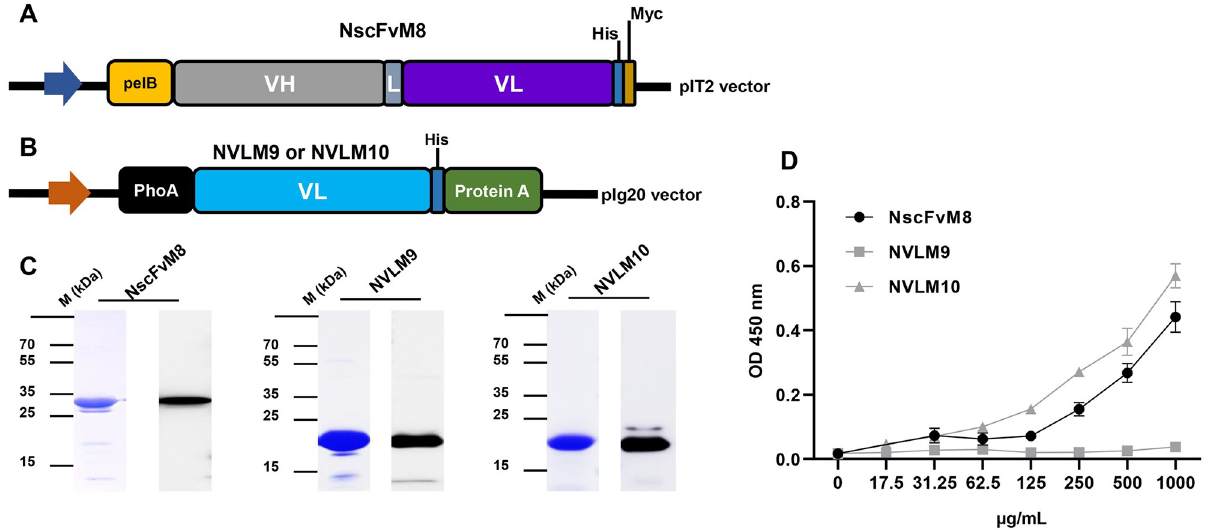
Fig 3. Production of selected candidates in E . coli and their respective virion binding affinities. (A) Expression vector of a single-chain variable fragment candidate, NscFvM8, in a pIT2 vector fused with pelB at the N terminal, and a His, cmyc tag at the C terminal. (B) Expression vector of 2 different single-domain V L candidates, NVLM9 and MVLM10. The single-domain V L genes were amplified and inserted into the pIg20 vector containing a PhoA signal peptide at the N terminal and fused with protein A to improve purification. (C) Purification results of three candidates confirmed by coomassie blue staining and western blotting using anti-His-Abs, with the size of each protein indicated, left, NscFvM8; middle, NVLM9; right, NVLM10. (D) Virion ELISA results showing purified candidates bound to virus particles in a concentration-dependent manner. The background was subtracted.